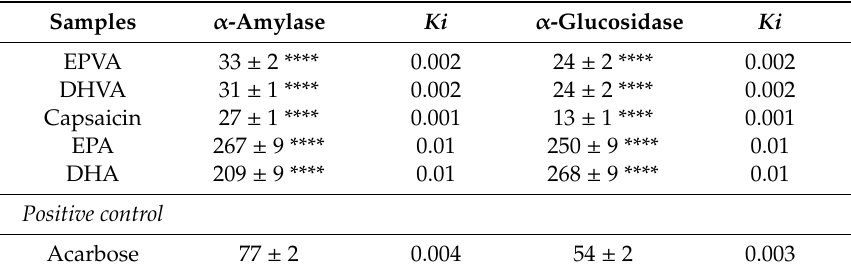
Table 1. Carbohydrate-hydrolysing enzyme inhibitory activities (IC 50 µ M).